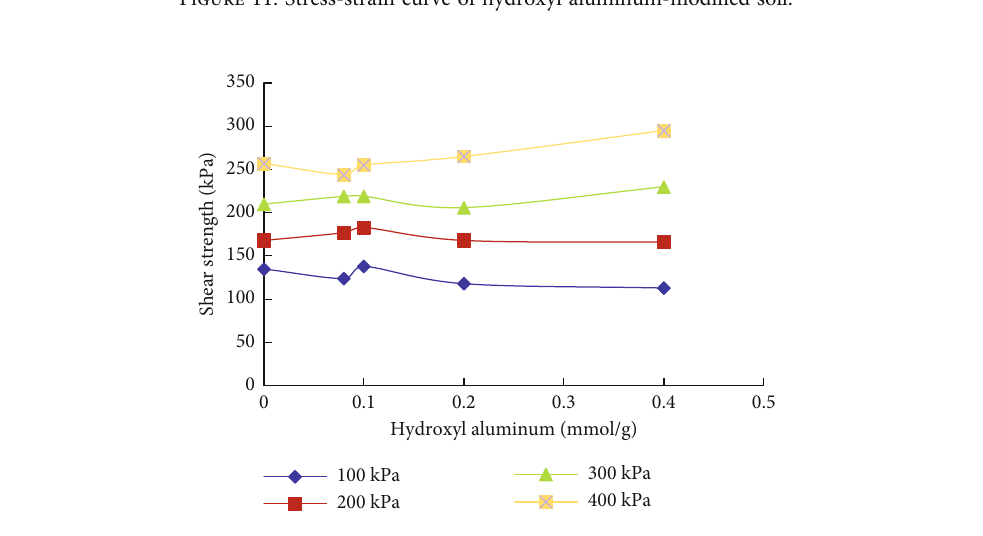
Figure 12: Shear strength changes of the modi fi cation clay sample.